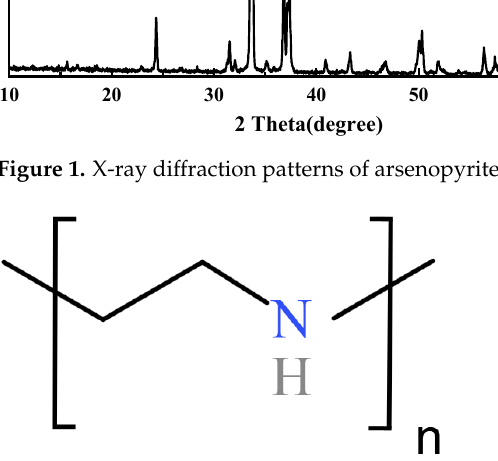
Figure 2. Monomer structure of linear polyethyleneimine.